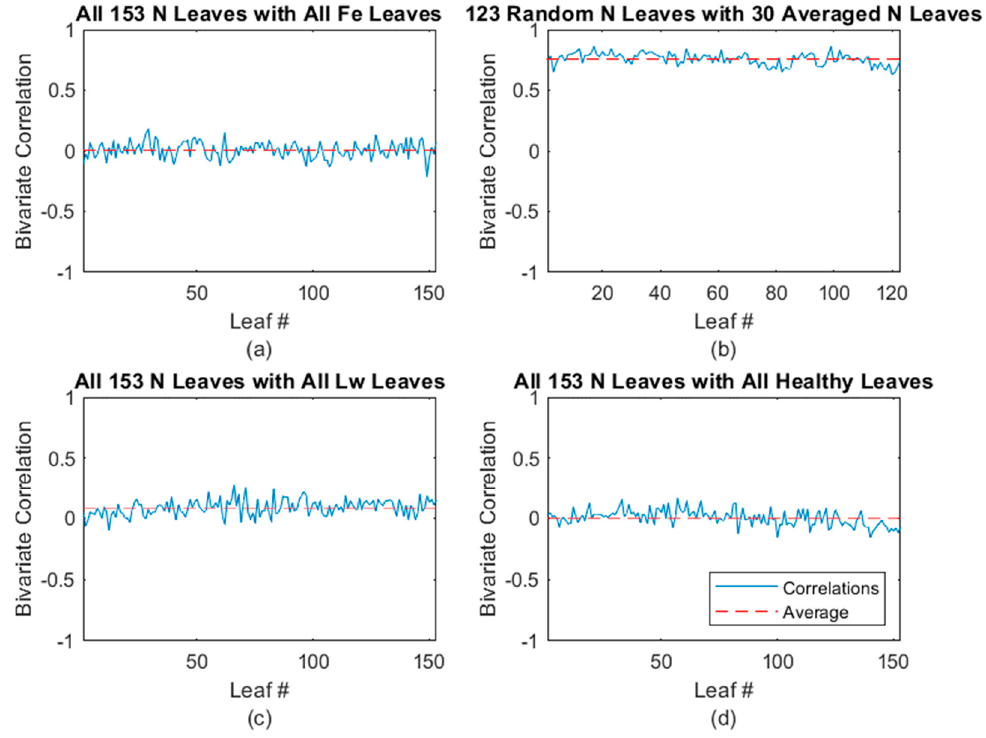
Figure 6. FDA-BC algorithm applied for N-deficient avocado leaves: ( a ) N-deficient correlated with Figure 6. FDA ‐ BC algorithm applied for N ‐ deficient avocado leaves: ( a ) N ‐ deficient correlated with Fe-deficient; ( b ) N-deficient correlated with N-deficient; ( c ) N-deficient correlated with Lw; and ( d ) Fe ‐ deficient; ( b ) N ‐ deficient correlated with N ‐ deficient; ( c ) N ‐ deficient correlated with Lw; and ( d ) N-deficient correlated with N ‐ deficient correlated with healthy.